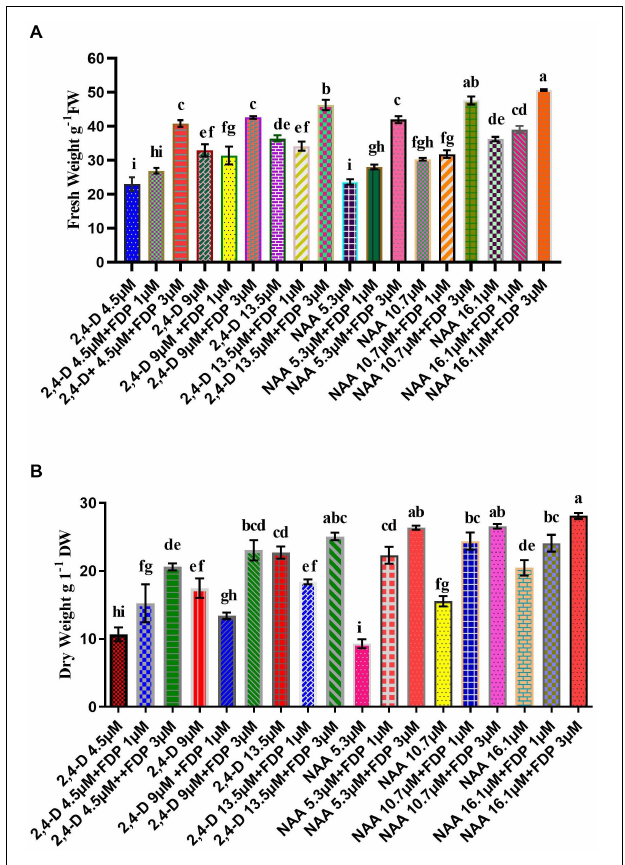
FIGURE 2 | Productivity of precursor treatment of callus culture yield and biomass cultivation. (A) Various concentrations of 2,4D + FDP and